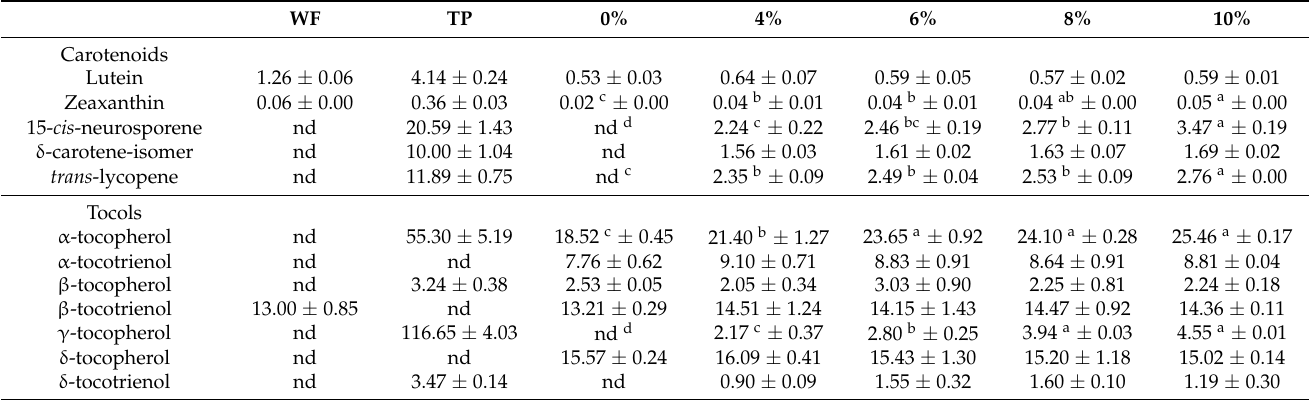
Table 4. Carotenoids and tocols contents (mg/kg DM; mean ± standard deviation) of wheat flour (WF), tomato pomace (TP), and cream crackers with increasing TP percentages. Different letters indicate significant differences ( p < 0.05) among cream crackers along a